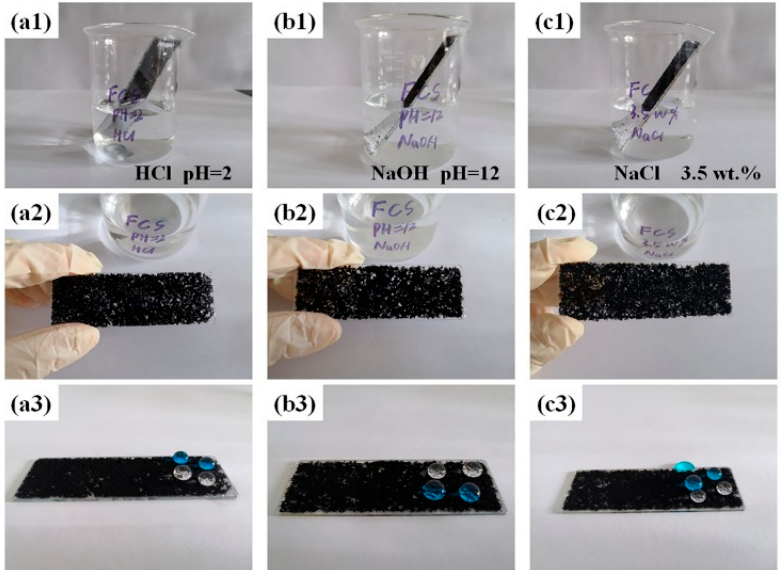
Figure 3. The superhydrophobic composite coatings against water droplets after dipping into ( a1 – a3 ) HCl (pH = 2), ( b1 – b3 ) NaOH (pH = 12), and ( c1 – c3 ) 3.5 wt. % NaCl aqueous solution for three days.